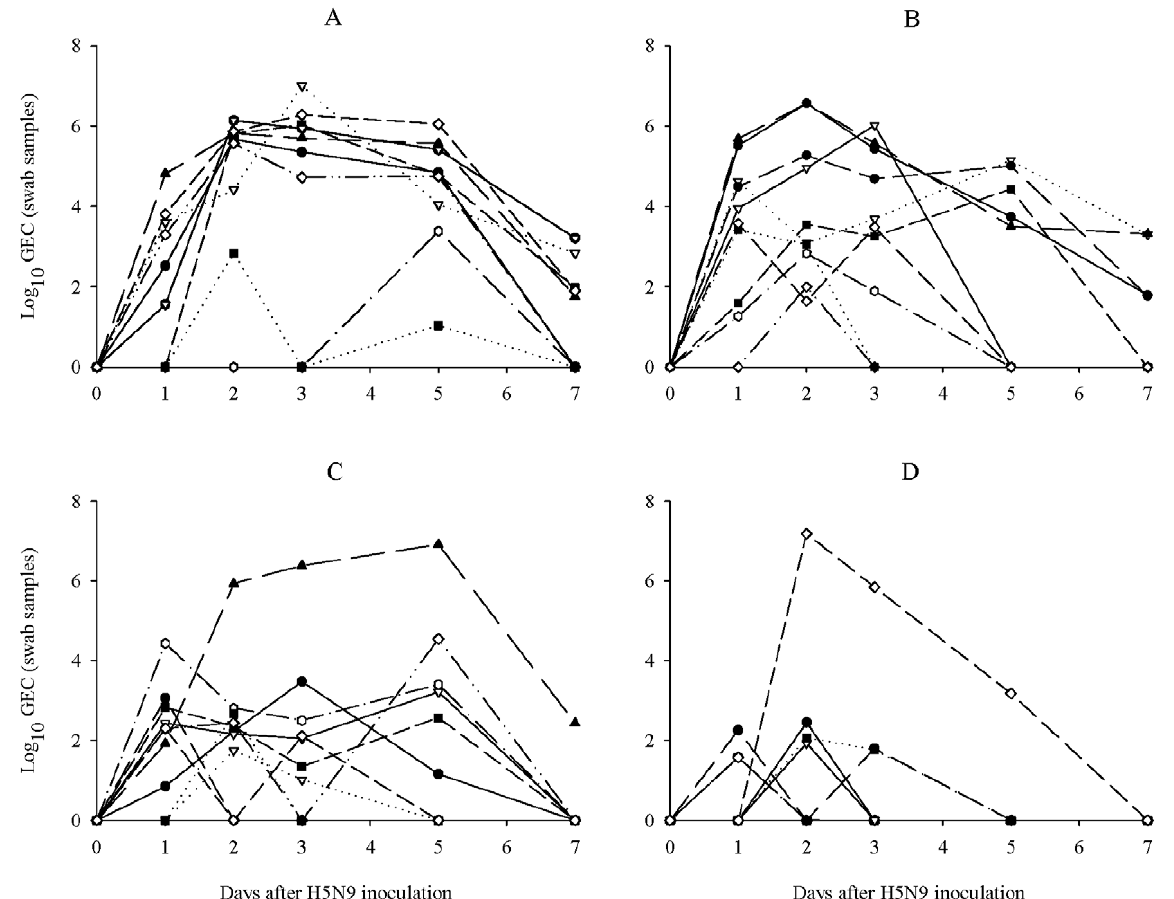
Figure 4. Viral shedding profiles (log 10 GEC/140 m l of swab sample fluid) for all infected mallards with detectable viral RNA using matrix gene RRT-PCR. A: captive-bred (n=9), B: wild normal (n=10), C: wild lean (n=10), D: wild poor (n=6). doi:10.1371/journal.pone.0022633.g004 PLoS ONE |